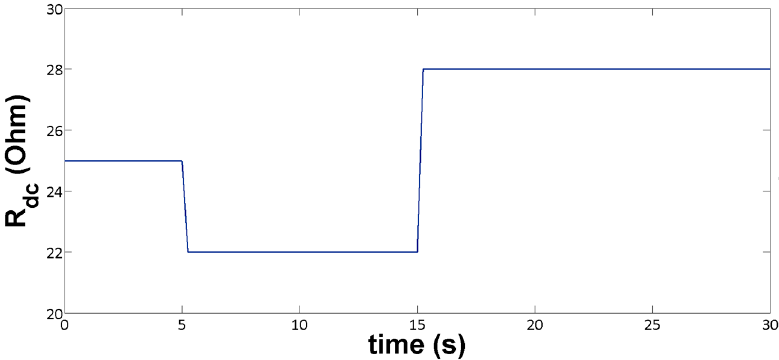
Figure 4. Change of the resistive part of the load.